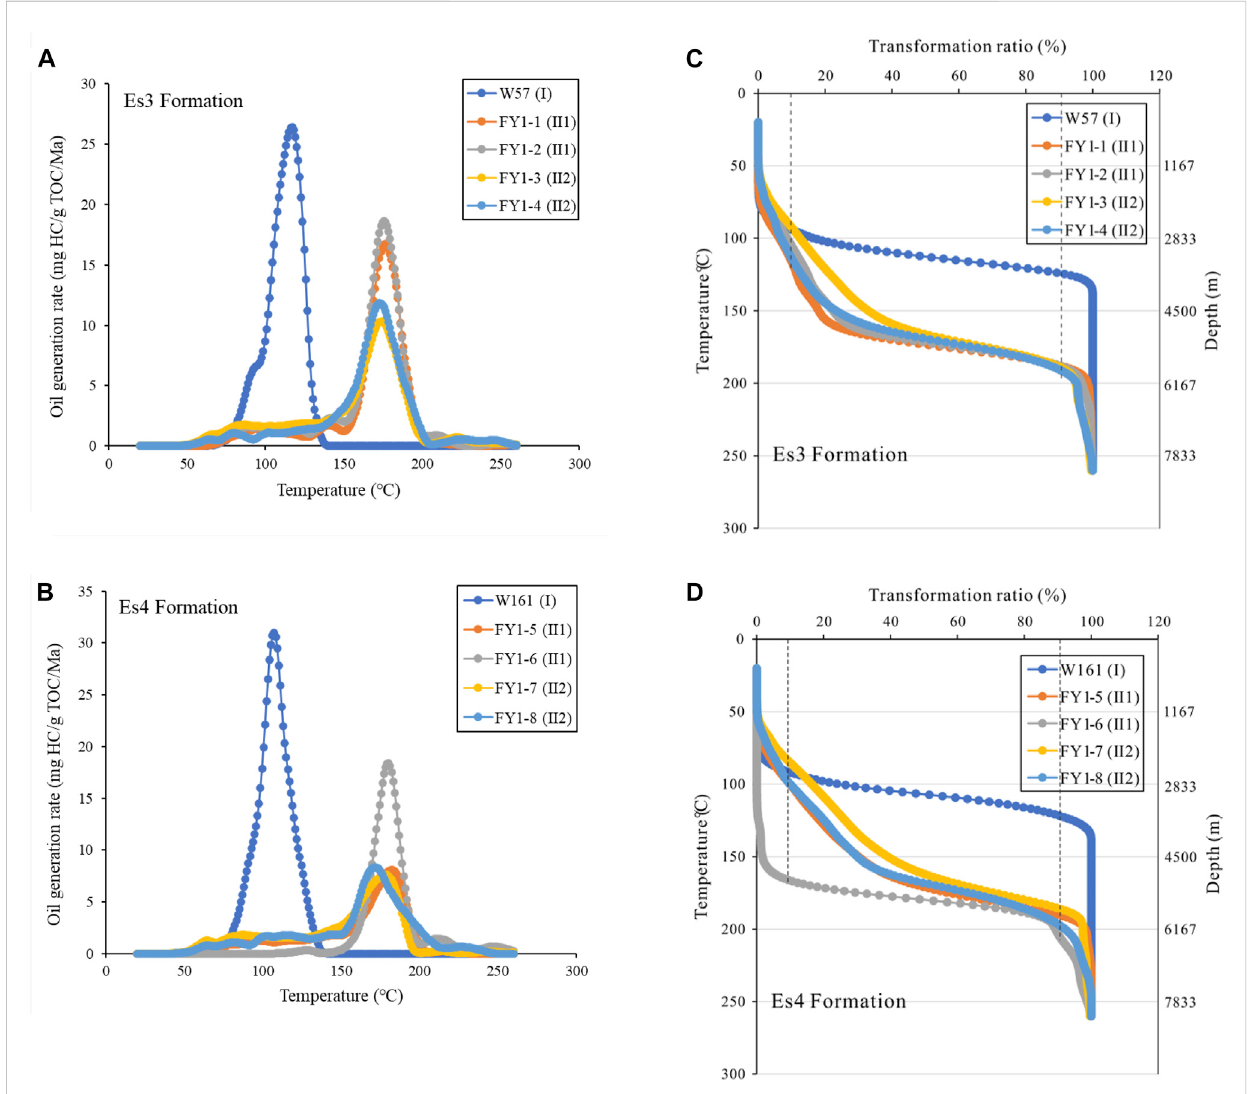
FIGURE 10 Geological extrapolation to obtain oil generation rates and transformation ratios from kinetic experimental results of the Es3 and Es4 samples assuming a geological heating rate of 3 ° C/Ma. (A) Oilgeneration rate versus temperaturein the Es3 formation; (B) Oil generation rate versus temperature intheEs4formation; (C) Transformationratio versus temperatureanddepthintheEs3formation; (D) Transformationratio versus temperatureanddepth in the Es4